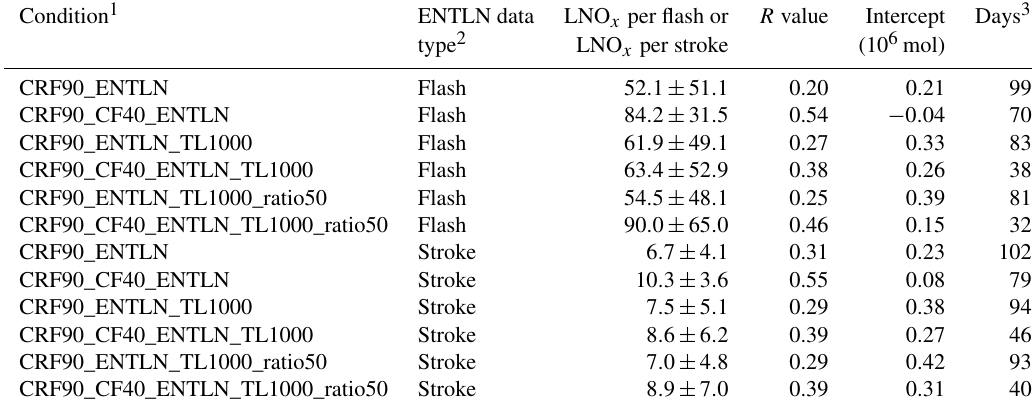
Table 2. LNO x production efficiencies for different combinations of criteria defined in Table 1. Condition